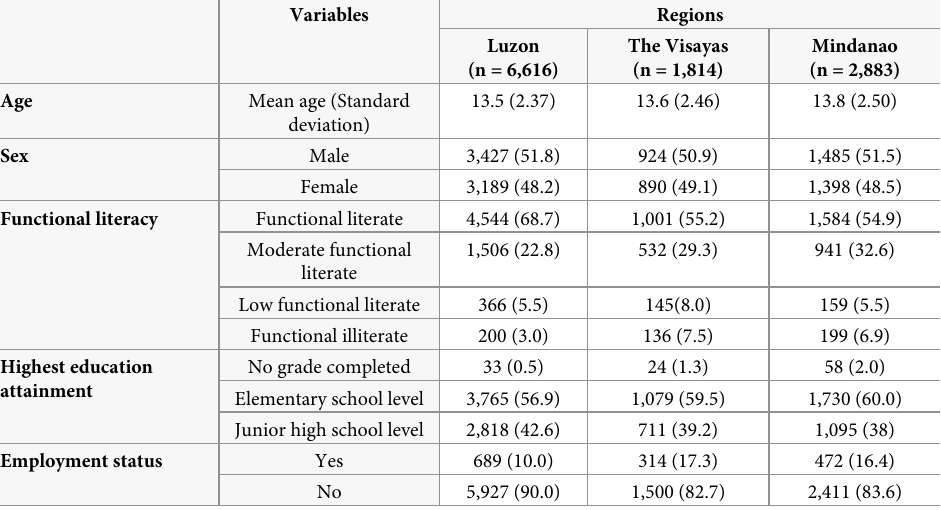
Table 5. Demographic characteristics of children, stratified by regions of the